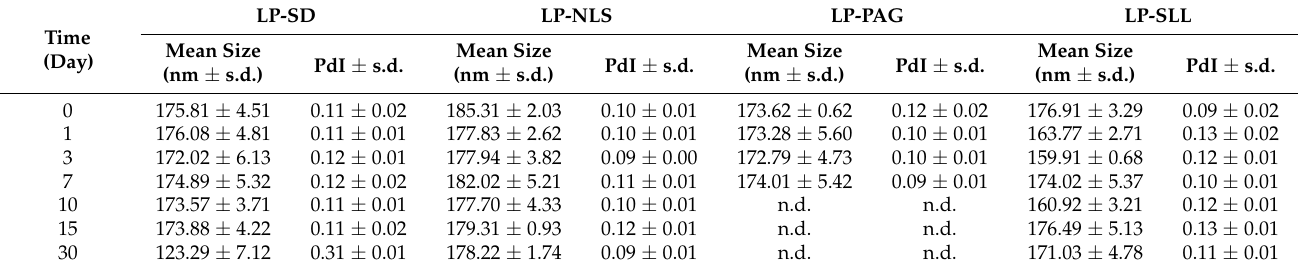
Table 3. Liposome mean size and polydispersity index (PdI) during one month, as determined by